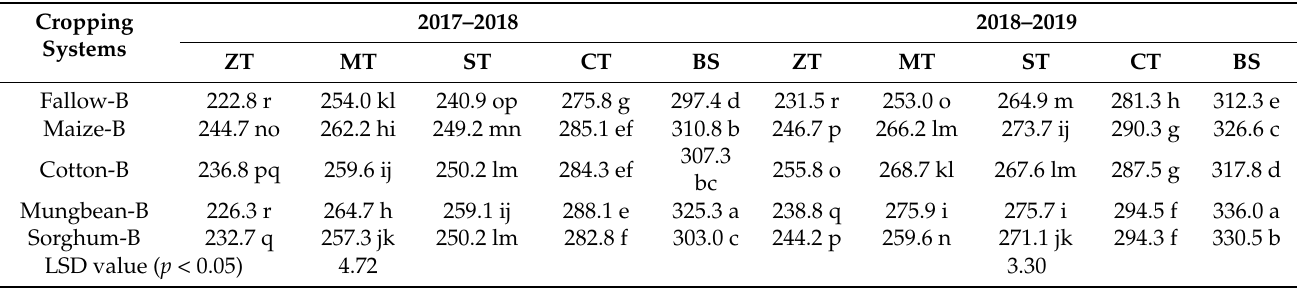
Table 4. Impact of different barley-based cropping systems on dry biomass yield (g m − 2 ) of barley under conservation and conventional tillage